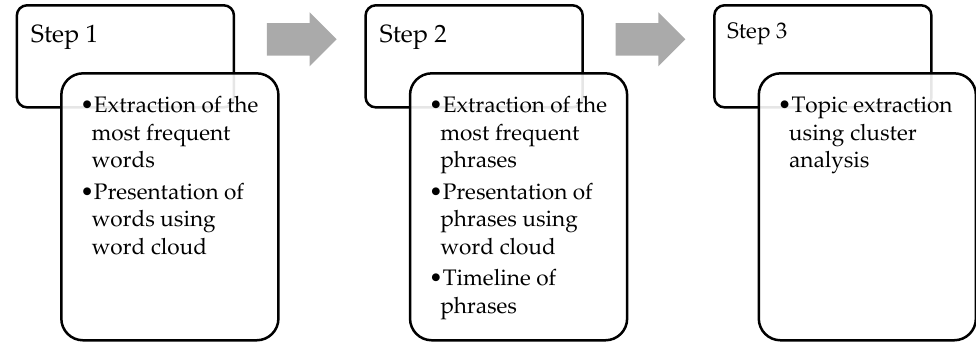
Figure 3. Stages of ALR; Source: Authors’ work.